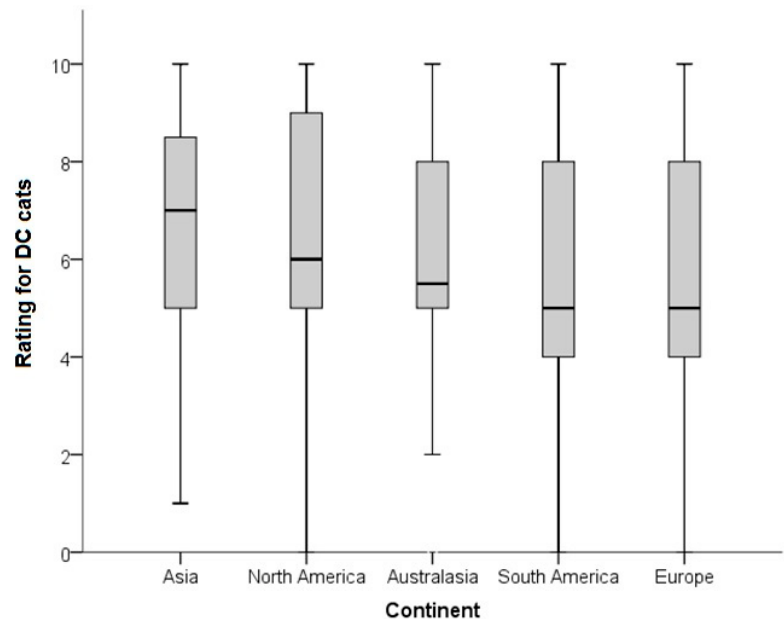
Figure 5. Ratings of liking (0 = I don’t like this cat at all; 10 = This is my favorite kind of cat) for cats identified as having mild to extreme dolichocephaly (DC; n = 4/15 cat images as per Table 1). Ratings were provided by respondents ( n = 1239) to two questionnaires. Comparisons are between different continental regions.